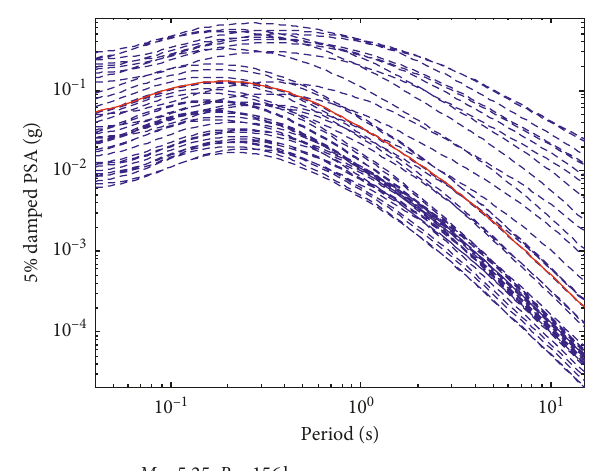
Figure 7: PSA for all point sources ( M